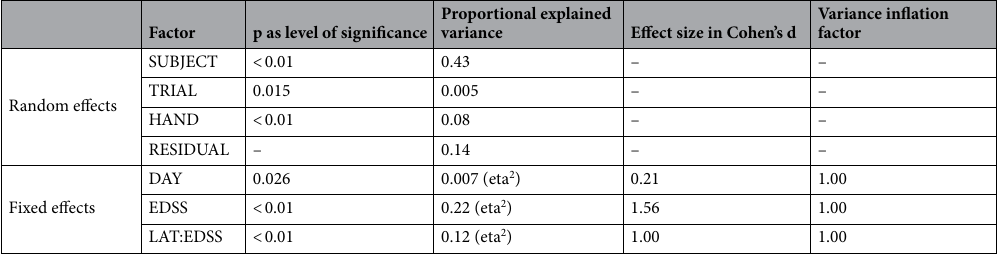
Table 4. Characteristics of the linear-mixed effects model.